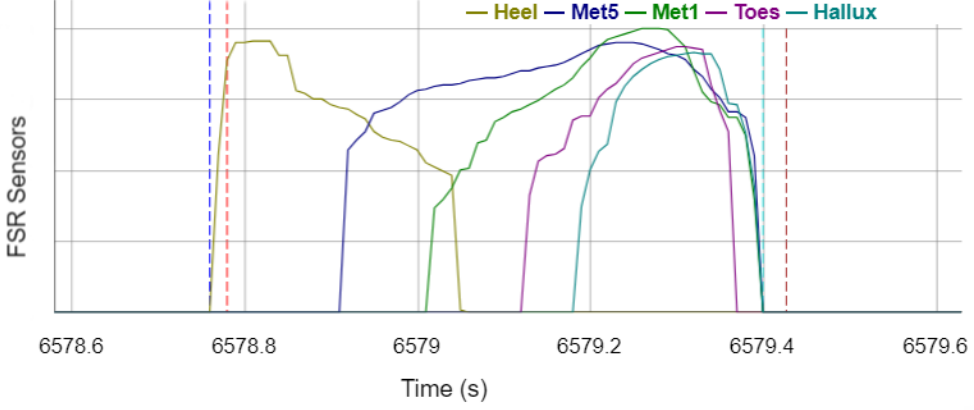
Figure 3. Signals of the FSR sensors of the sensor sock during the stance phase with annotated reference gait events and events recognized by the algorithm. Vertical dotted lines legend: red —reference IC Left ; brown—reference TO Left ; blue—sensor IC sock ; turquoise—sensor TO sock